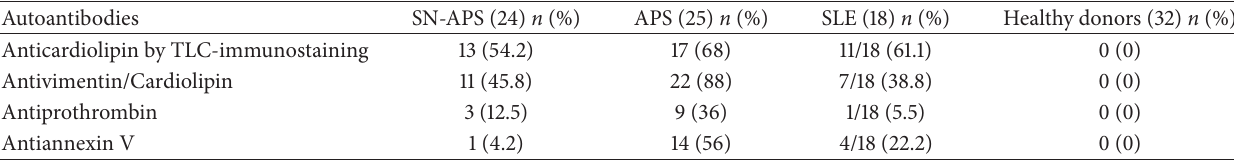
Table 2: Occurrence of autoantibodies in SN-APS and control sera.